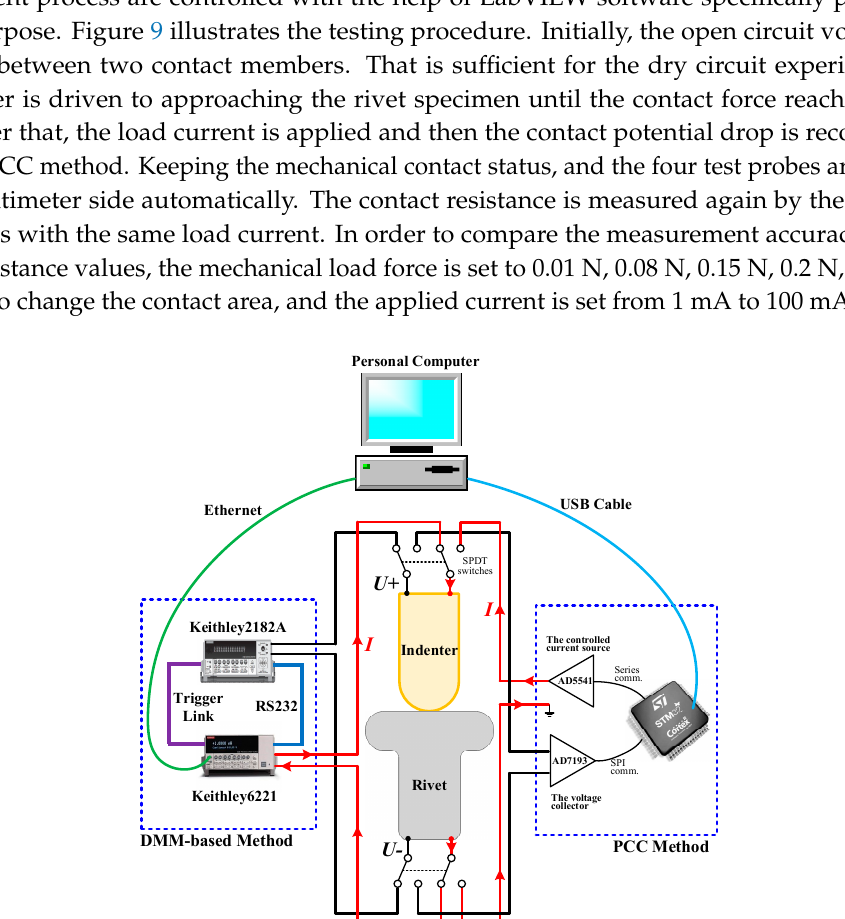
Output the open-circuit voltage